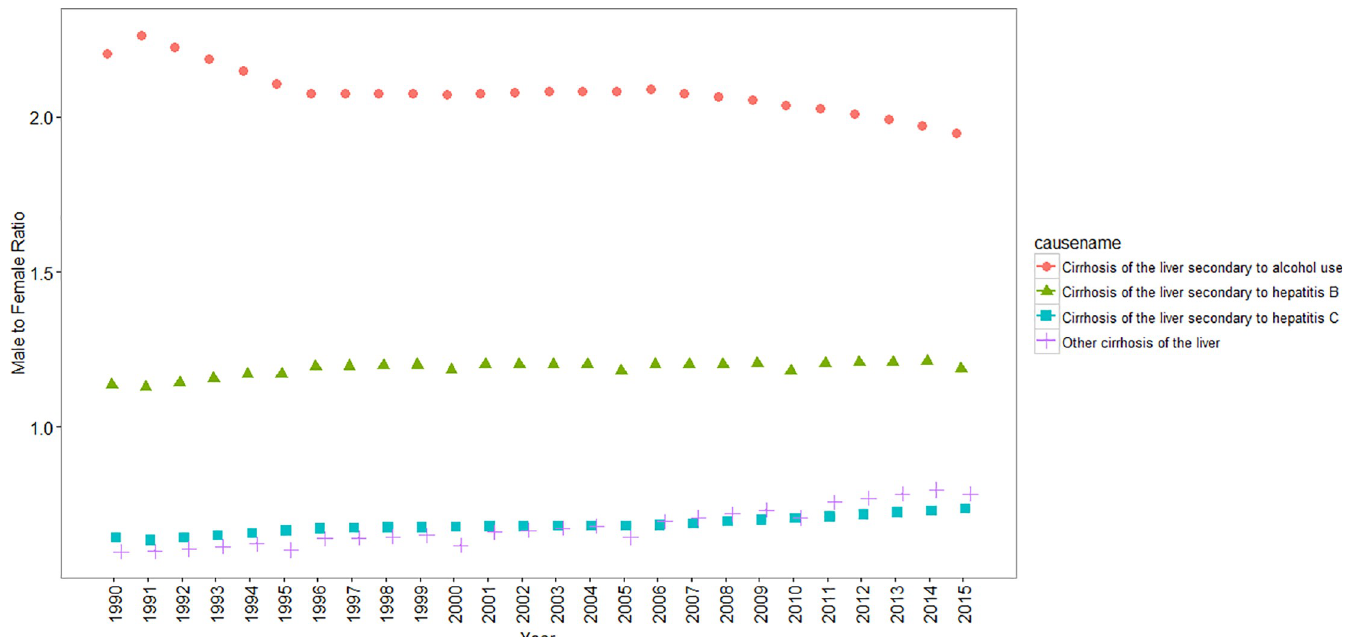
the cirrhosis death number had increasing pattern until 2000 and then decreased to minimum level till 2015. This pattern is compatible with maximum coverage of vaccination of hepatitis B